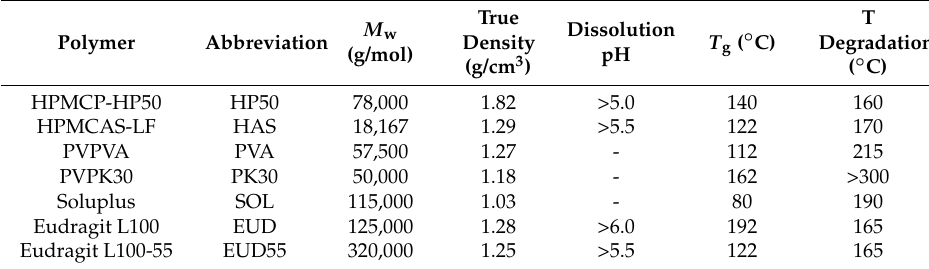
Table 2. Physico-chemical properties of selected polymers. HPMCAS-LF: